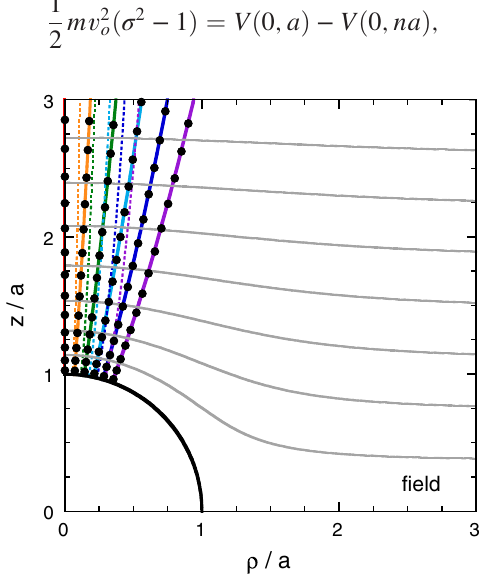
FIG. 14. Same as Fig. 12 but for field emission.